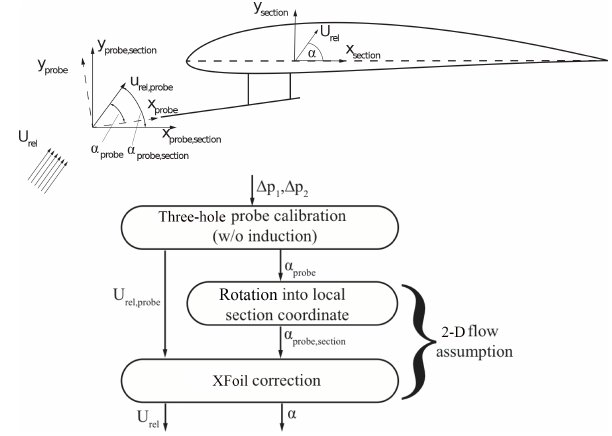
Figure 7. Schematic and flow chart of derivation of the sectionwise AoA (Bartholomay et al.,